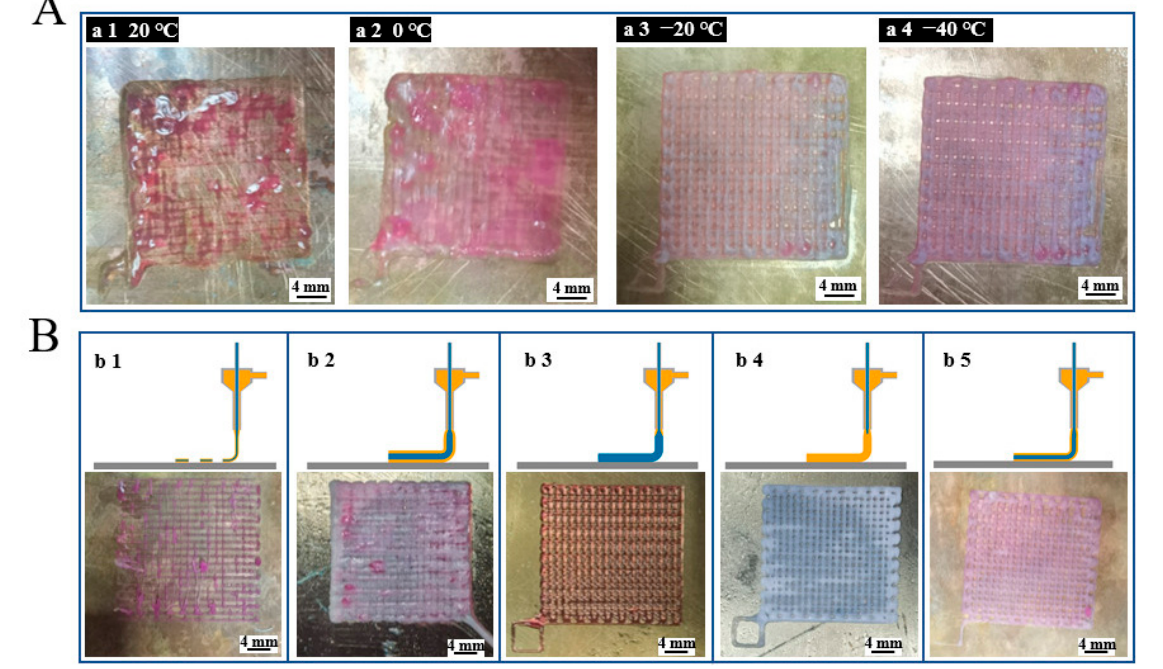
Figure 3. ( A ) Cryogenic coaxial printing under different temperatures; ( B ) cryogenic coaxial printing with different material feed speeds.